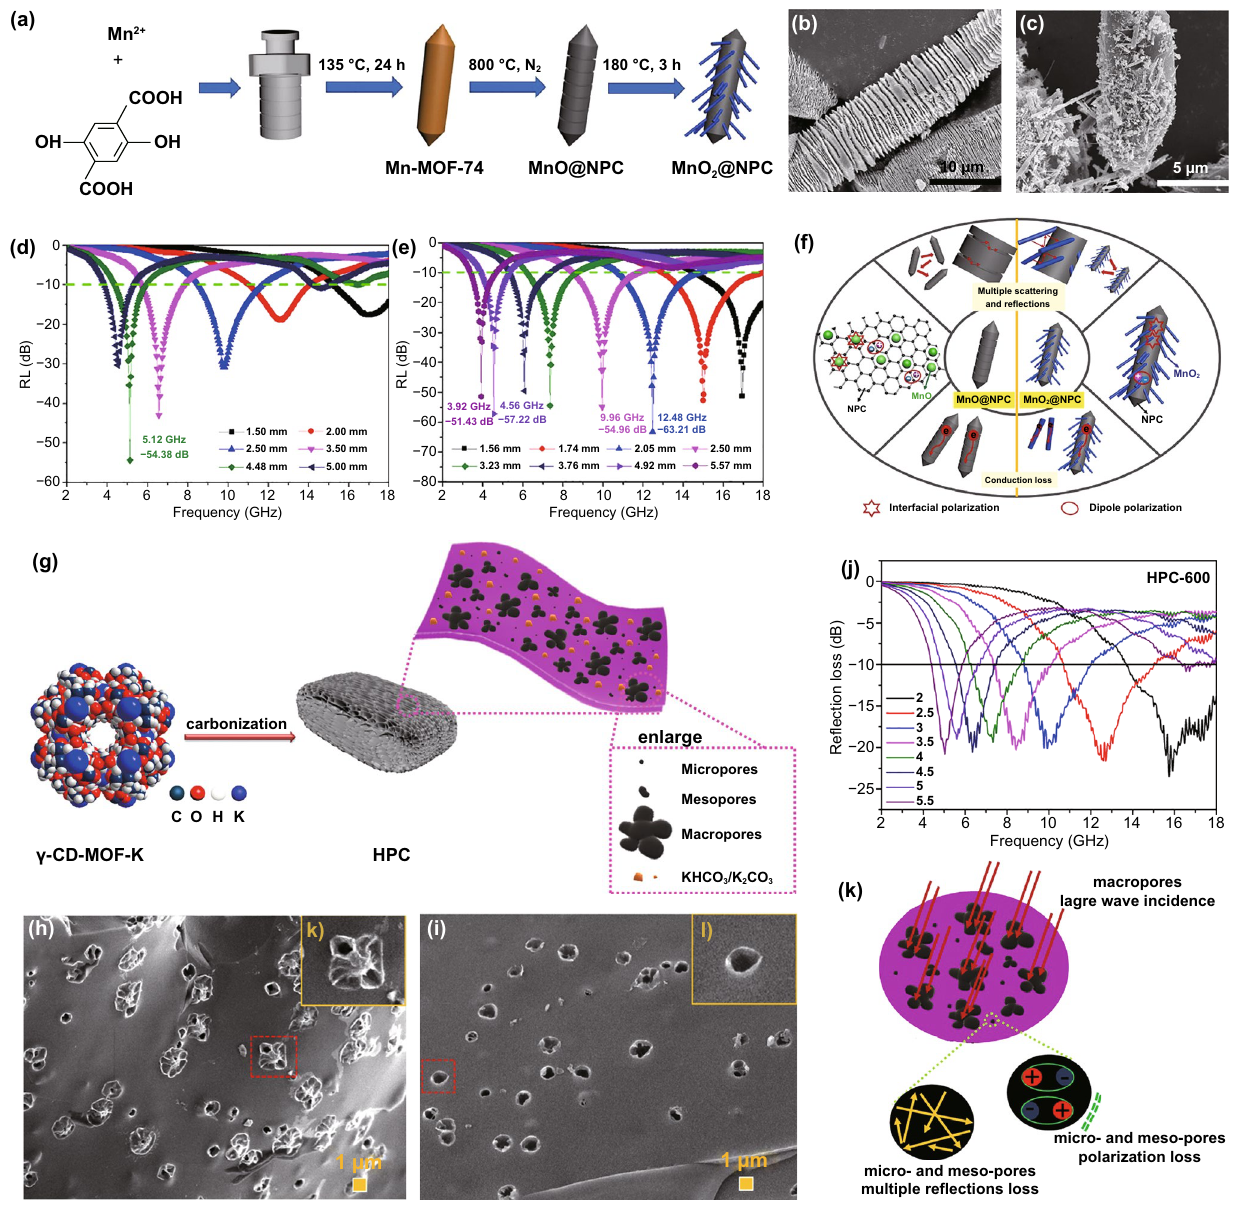
Fig. 8 a Schematic illustration of diagram of MnO@NPC and MnO 2 @NPC. TEM image and 3D RL-f curves of b, d MnO@NPC and c, e MnO 2 @NPC. f Schematic illustration of MA mechanisms for MnO@NPC and MnO 2 @NPC. Reprinted with permission from Ref. [108]. g Preparation process diagram of γ-CD-MOF-K-derived HPC. TEM images of h HPC-600 and i HPC-900. j RL-f curves and k MA mechanism of TiO 2 /C. Reprinted with permission from Ref.